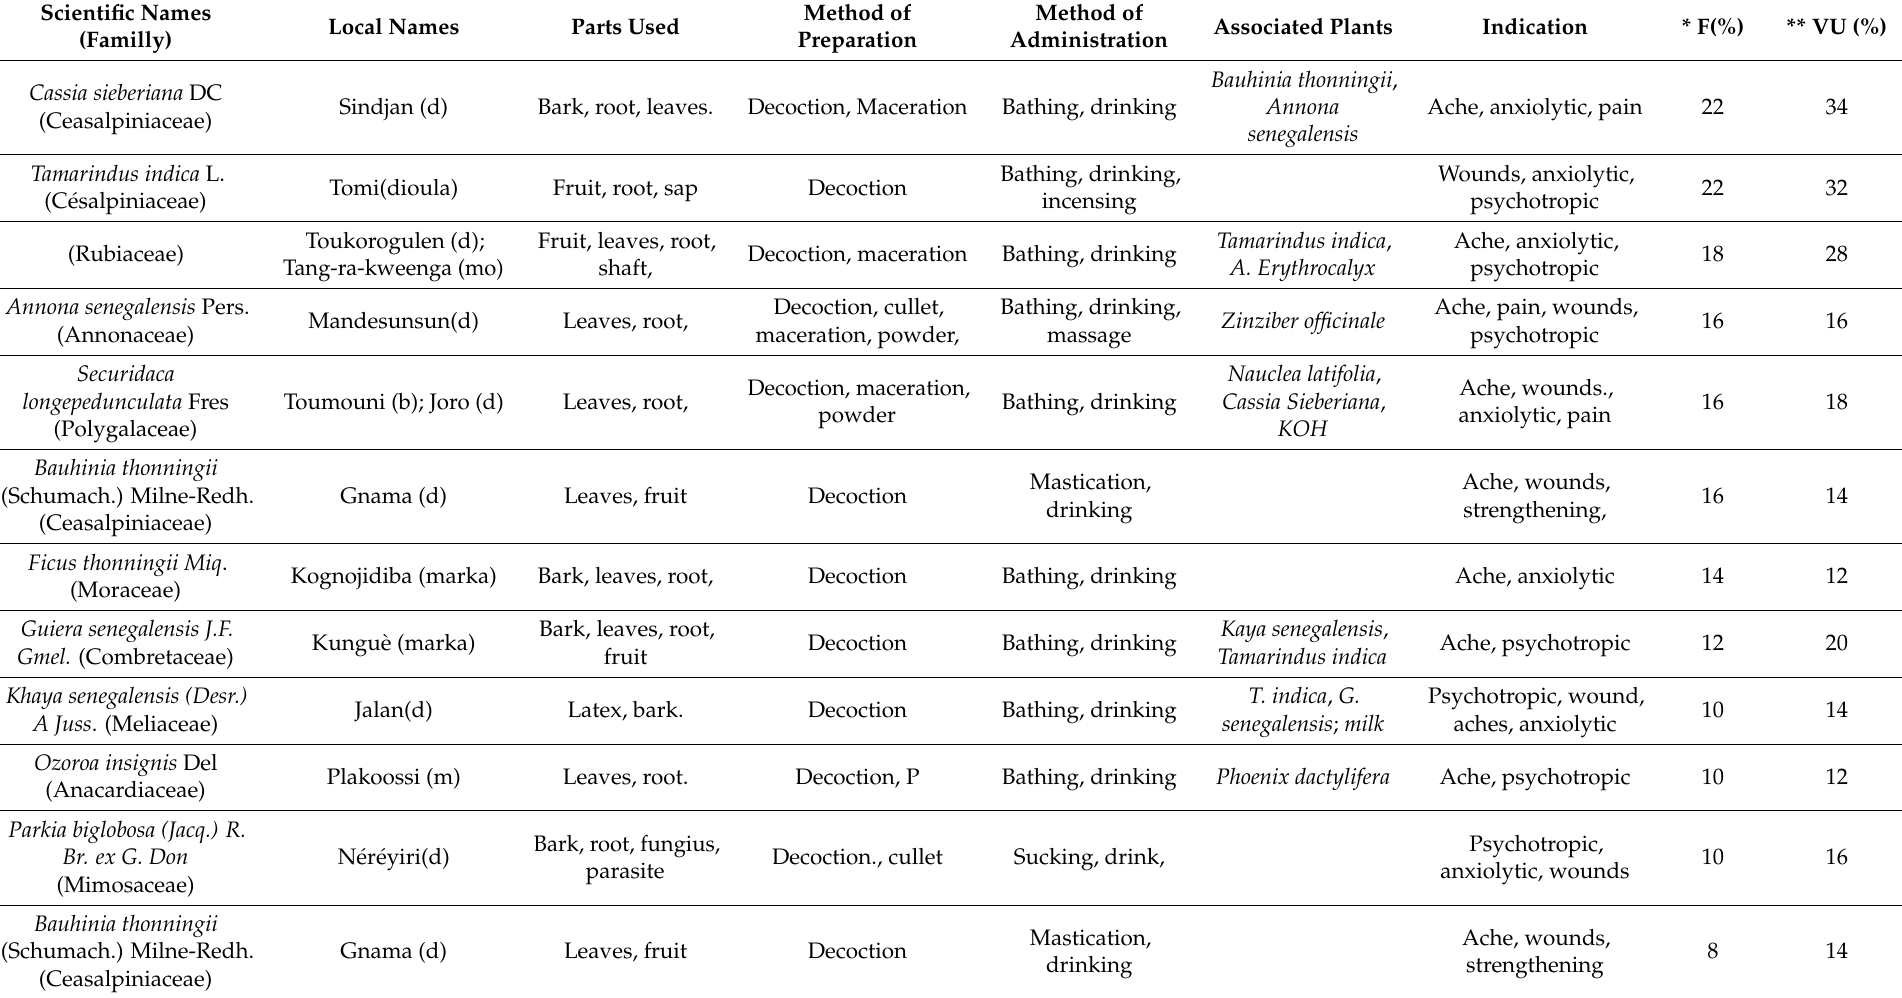
Table 2. Different species